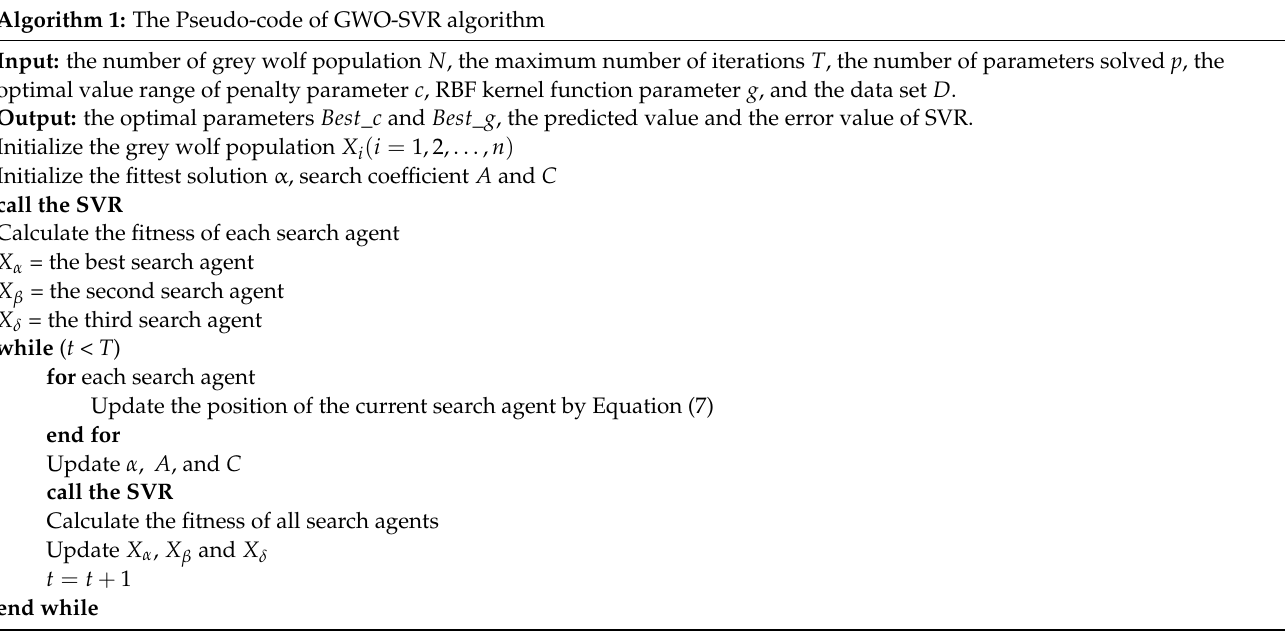
Algorithm 1: The Pseudo-code of GWO-SVR